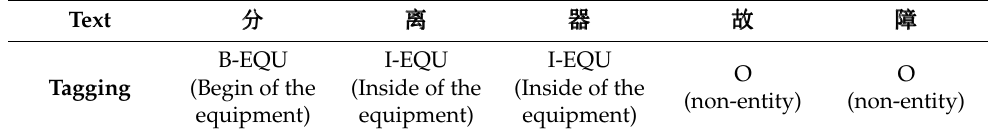
Table 2. A concrete example of data